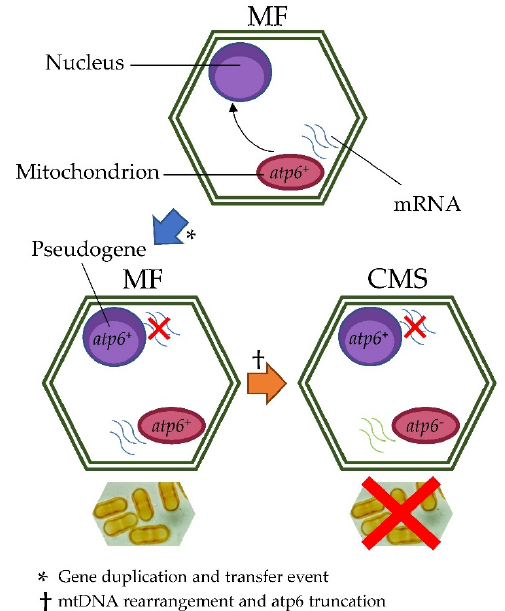
Figure 5. Involvement of atp6 in cytoplasmic male sterility in fennel. The atp6 + gene duplication and transfer from the mtDNA to the nuclear genome is a recurrent and consistent feature of eukaryotic genome evolution that seems to have characterized also the evolutionary path of Foeniculum vulgare . Subsequently, a mitochondrial rearrangement event produced a truncation of 300 bp in the mtDNA atp6 copy ( atp6 − ) leading to a cytoplasmic male sterility phenotype. Expression analyses revealed that (i) atp6 + gene is constantly expressed in male fertile plants (MF), where it is available both in the mtDNA and, probably, in the nuclear DNA (ii) atp6 + gene is never expressed in male sterile plants, where is available only in the nuclear DNA (probably as pseudogene) (iii) atp6 − is constantly expressed in male sterile plants (MF), where is available in the